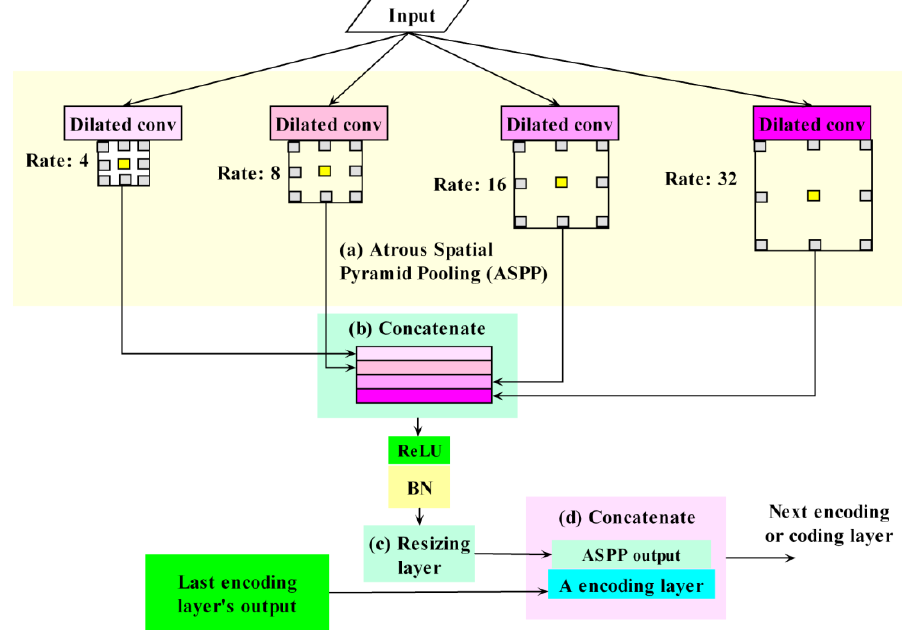
Figure 3. An ASPP module for embedding in the segmentation model.